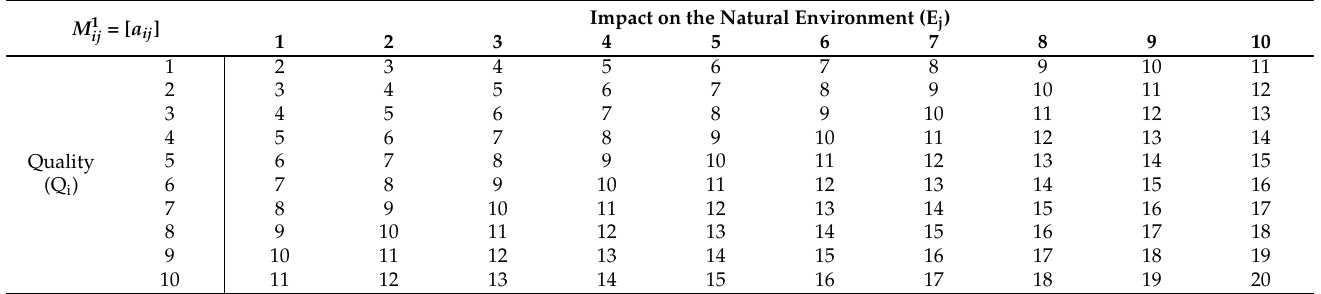
Table 5. Values of the sum of quality and environmental impact assessments determined during the creation of the selection matrix of the quality-environmental indicator